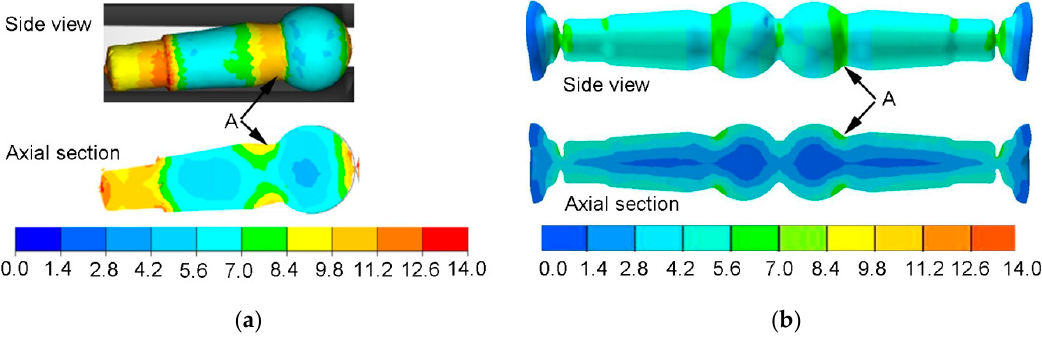
Figure 6. Distribution of e ff ective strain: ( a ) helical-wedge rolling (HWR) ball stud; ( b ) cross-wedge rolling (CWR) ball stud.